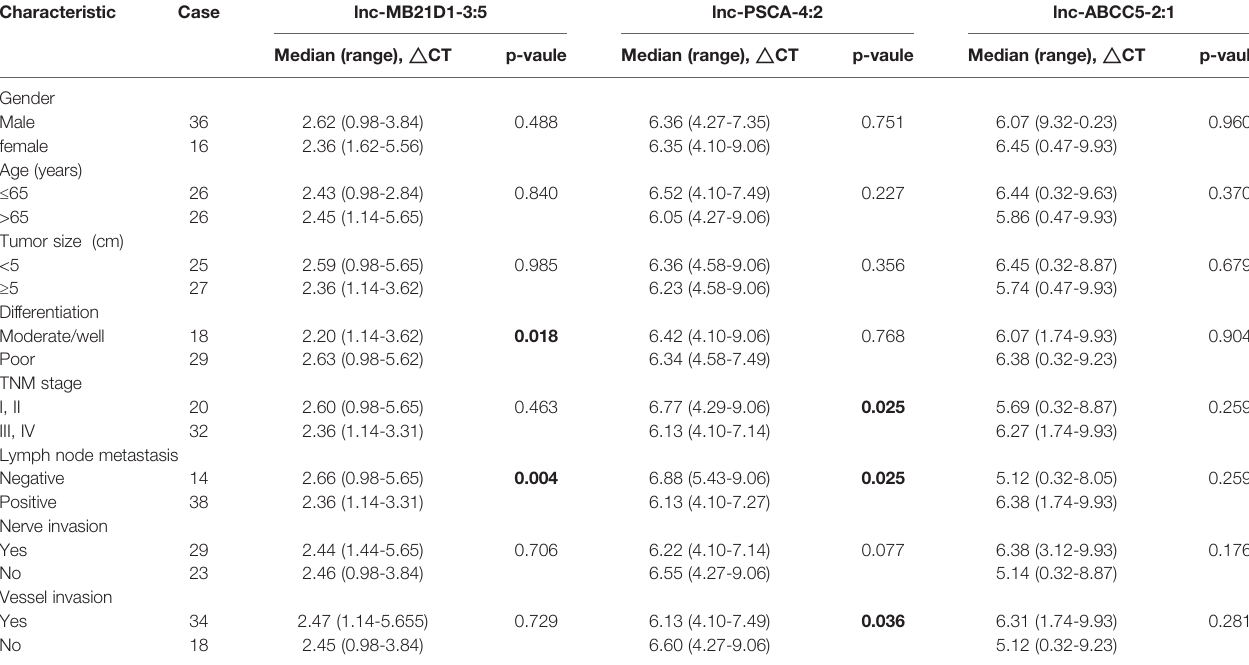
TABLE 2 | Correlation between clinicopathological features and expression levels of lncRNA in plasma with gastric adenocarcinoma.